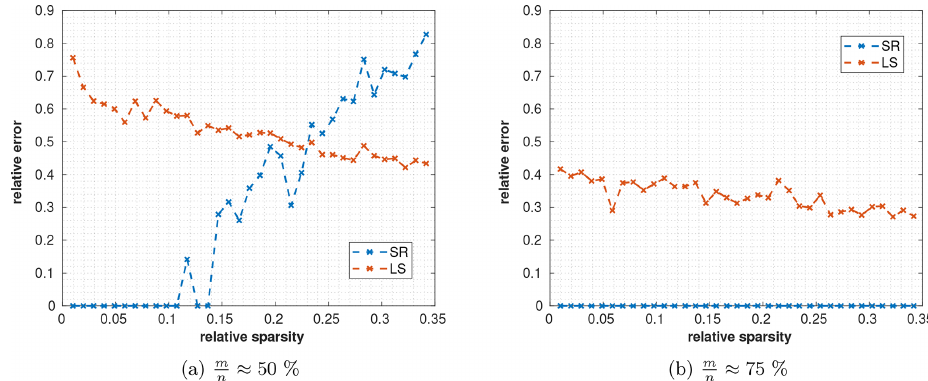
Figure C1. Reconstruction errors for sparse cities with (a) 50% and (b) 75% measurements m per emission fields n . Using SR (blue line), it is possible to reconstruct sparse emissions. By increasing the number of measurement stations, and therefore observations, more emitters can be reconstructed using SR ( a up to 13%; b up to 35% non-zero emission cells). For the LS method (red line), the relative error decreases both for less sparse signals and with a larger number of observations.